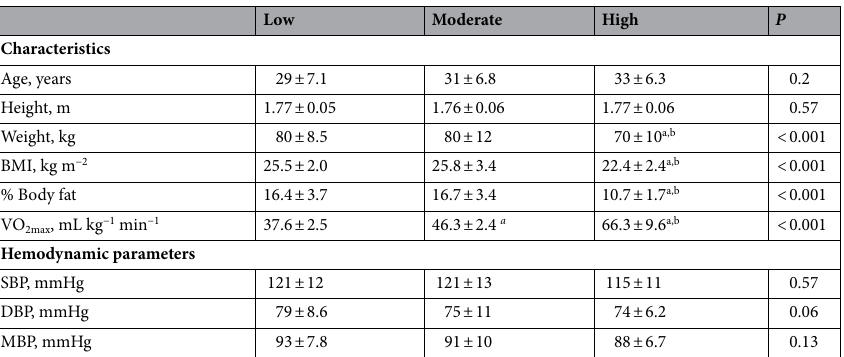
Table 1. Anthropomorphic characteristics and hemodynamic parameters of all groups. Values are presented as mean ± SD. m meter, kg kilograms, % percentage, VO 2max oxygen consumption maximum, mL milliliters, min minute, mmHg millimeters of mercury, SBP systolic blood pressure, DBP diastolic blood pressure, MBP mean blood pressure. a P < 0.05 vs. low cardiorespiratory fitness group. b P < 0.05 vs. moderate cardiorespiratory fitness group.